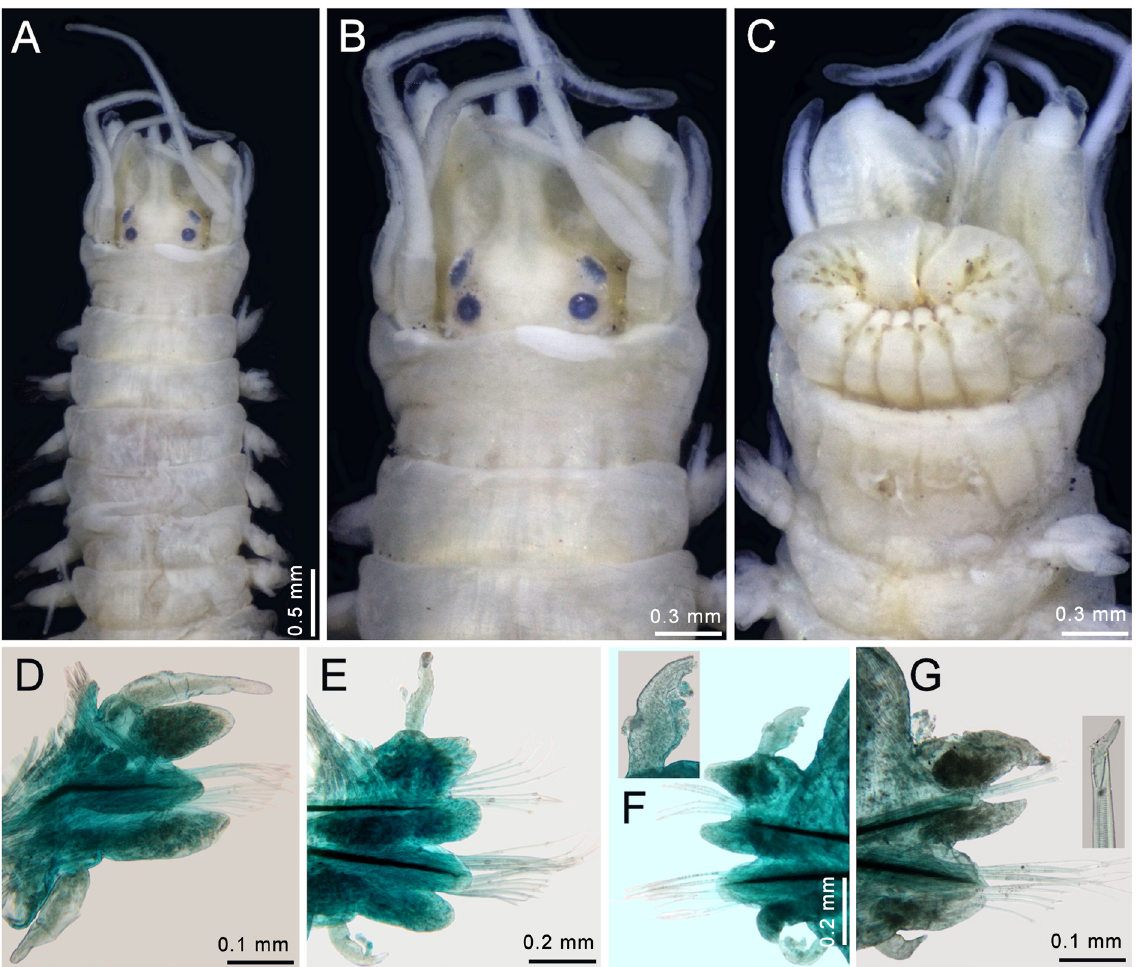
Fig. 15. Nereis lunulata Ehlers, 1901 stat. nov., non-type specimen (MNHN 83-T52). A . Anterior region, dorsal view. B . Anterior end, dorsal view. C . Anterior end, ventral view. D . Chaetiger 2, left parapodim, anterior view. E . Chaetiger 14, left parapodium, anterior view. F . Chaetiger 30, left parapodium, posterior view (inset: close-up of dorsal cirrus). G . Chaetiger 56, left parapodium, anterior view (inset: homogomph